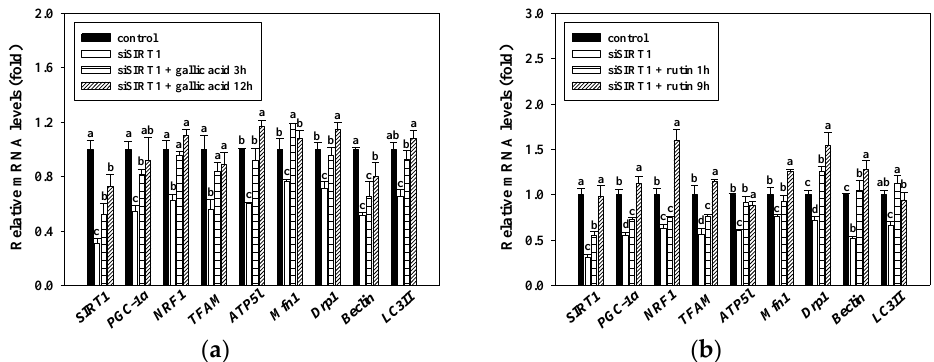
Figure 5. Effects of gallic acid ( a ) and rutin ( b ) on gene expressions of mitochondrial functions with SIRT1 siRNA transfection in C2C12 myotubes. C2C12 myotubes were transfected with SIRT1 siRNA by using Lipofectamine ® RNAiMAX reagent. After transfection, cells were treated with 25 µ M of gallic acid (3 and 12 h) or rutin (1 and 9 h) at 37 ◦ C in a humidified 5% CO 2 incubator. The reported values are the means ± SD ( n = 3). Mean values with different letters were significantly different ( p <